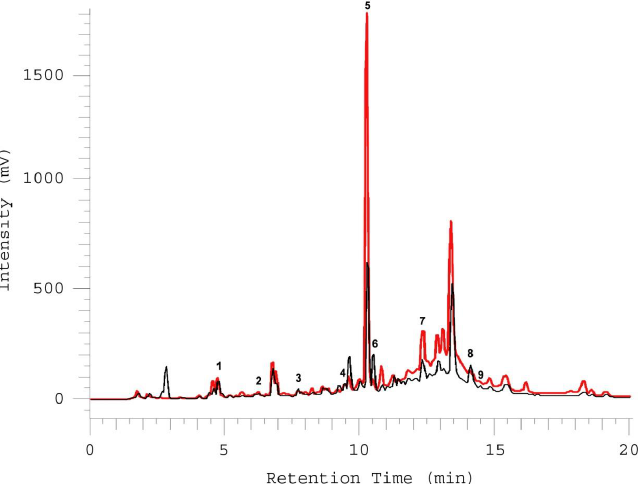
Figure 3. Chromatographic phenolic profile of ‘Cobrançosa’ (black) and ‘Galega Vulgar’ (red, thickener line) olive fruits, belonging to block I at S1 sampling period. Identified phenolic compounds (PCs): ( 1 ) hydroxytyrosol (HT); ( 2 ) tyrosol; ( 3 ) vanillic acid; ( 4 ) rutin; ( 5 ) verbascoside (VERB); ( 6 ) ferulic acid; ( 7 ) oleuropein (OLE); ( 8 ) luteolin; ( 9 ) cinnamic acid.